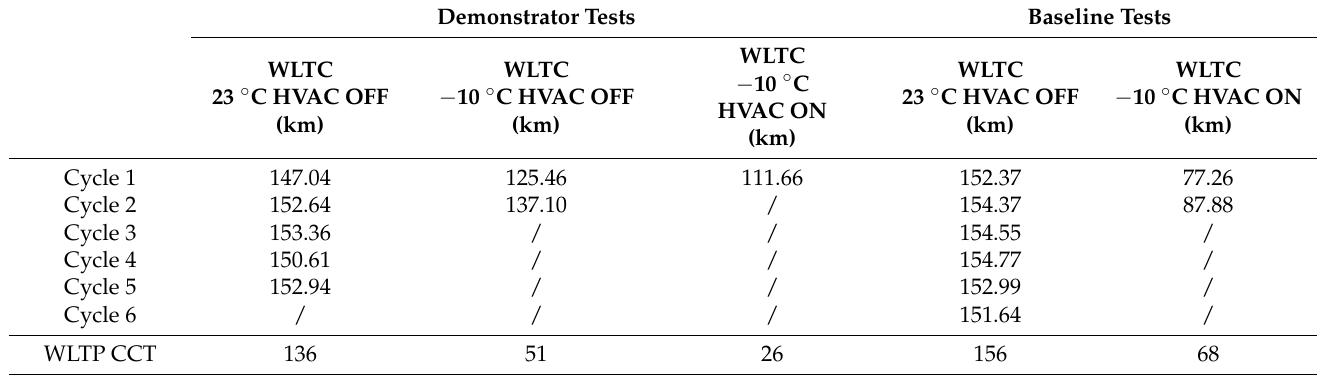
Table 9. Multi-cycle driven range Table 9. Multi ‐ cycle driven range results. Table 9. Multi ‐ cycle driven range results.